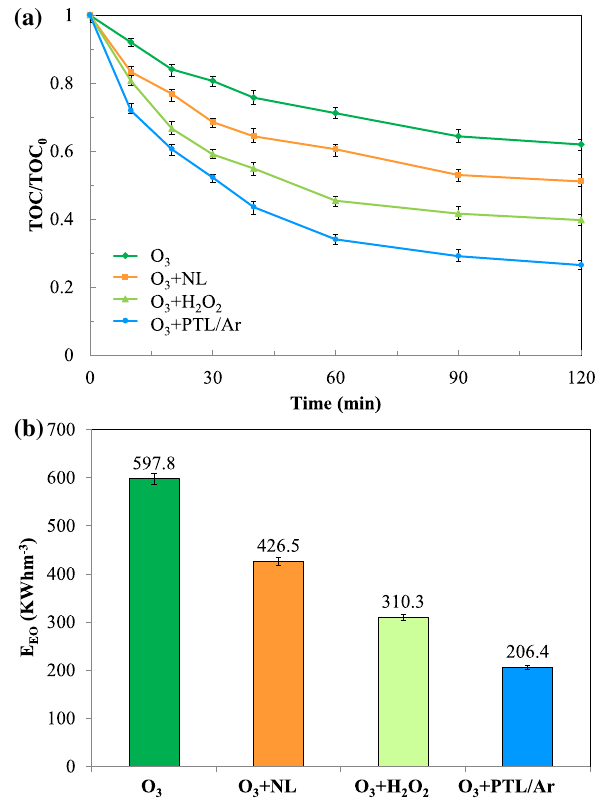
Figure 12. Comparison of TOC removal (a) and electrical energy consumption (b) in different oxidation processes, ([PhP] 0 = 30 mg/L, [O 3 ] 0 = 11 mg/L, catalyst dosage = 0.75 g/L, [H 2 O 2 ] 0 = mg/L, pH 0 = 6.7, P = 69 W for production of 4 g/h O 3